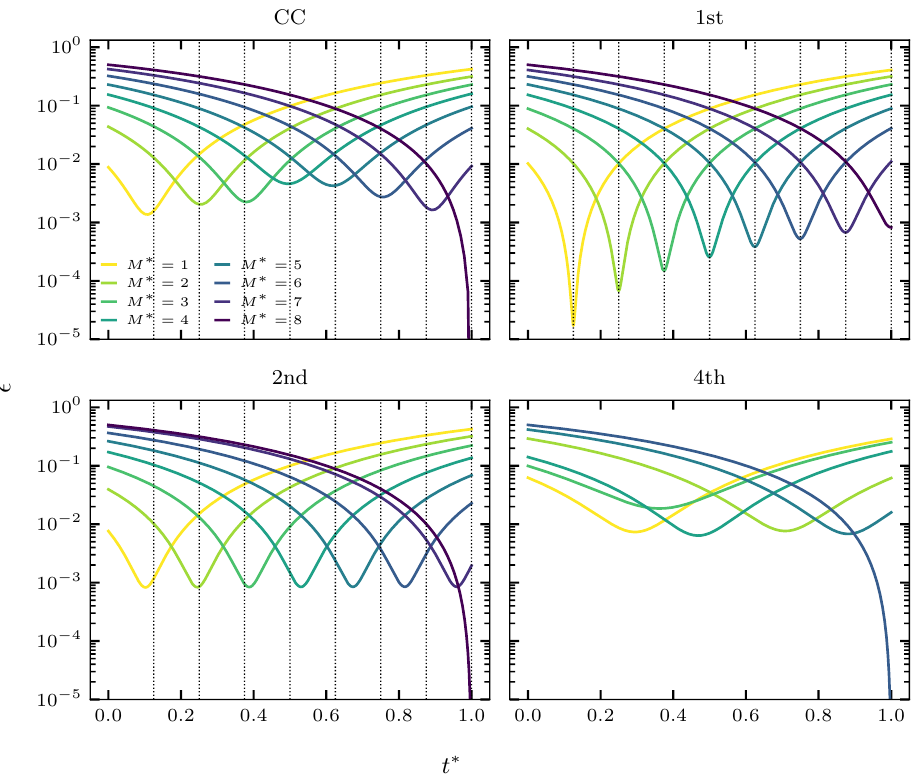
Figure 9: The infidelity between a subset of layers M ∗ < M , counting from the bottom layer, and the targeted time evolution operator at time t ∗ < t , where t denotes the time-step at which the compressed circuit was optimized. The plots are for a Heisenberg chain with L = 8 at t = 1. In the top left panel we show the results for a compressed circuit with M = 8, in the top right for a first-order Trotter circuit with M = 8, in the bottom left for a second-order Trotter circuit with M = 7, and in the bottom right for a fourth-order Trotter circuit with M = 1. These depths were chosen such that the circuits have similar gate count. The curve with M ∗ = M corresponds to the full circuit. The dashed lines mark times tM ∗ /